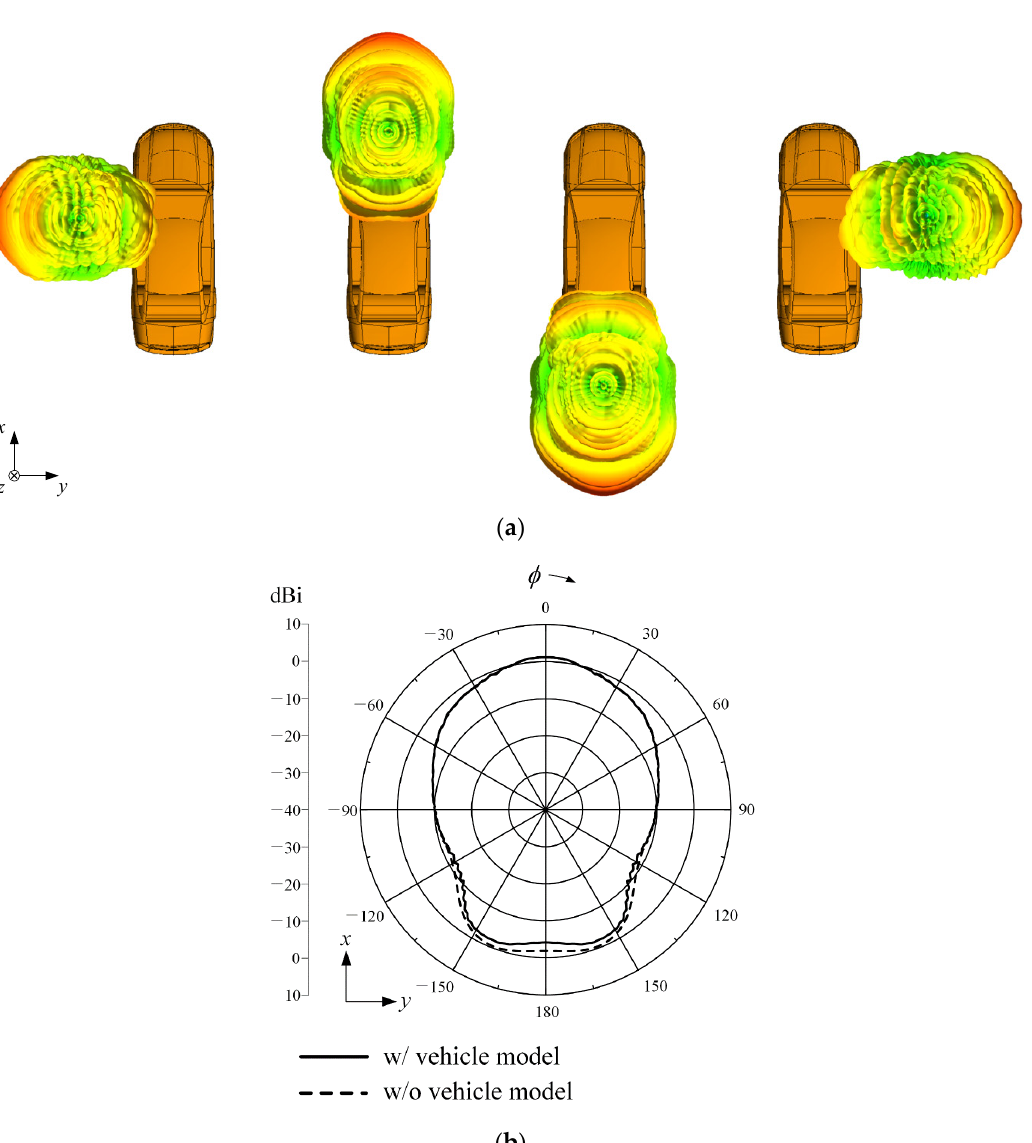
Figure 10. Bore-sight gain and reflection coefficient in accordance with the variations of parameters w 5 and g 3 : ( a ) bore- sight gain; ( b ) reflection coefficient.